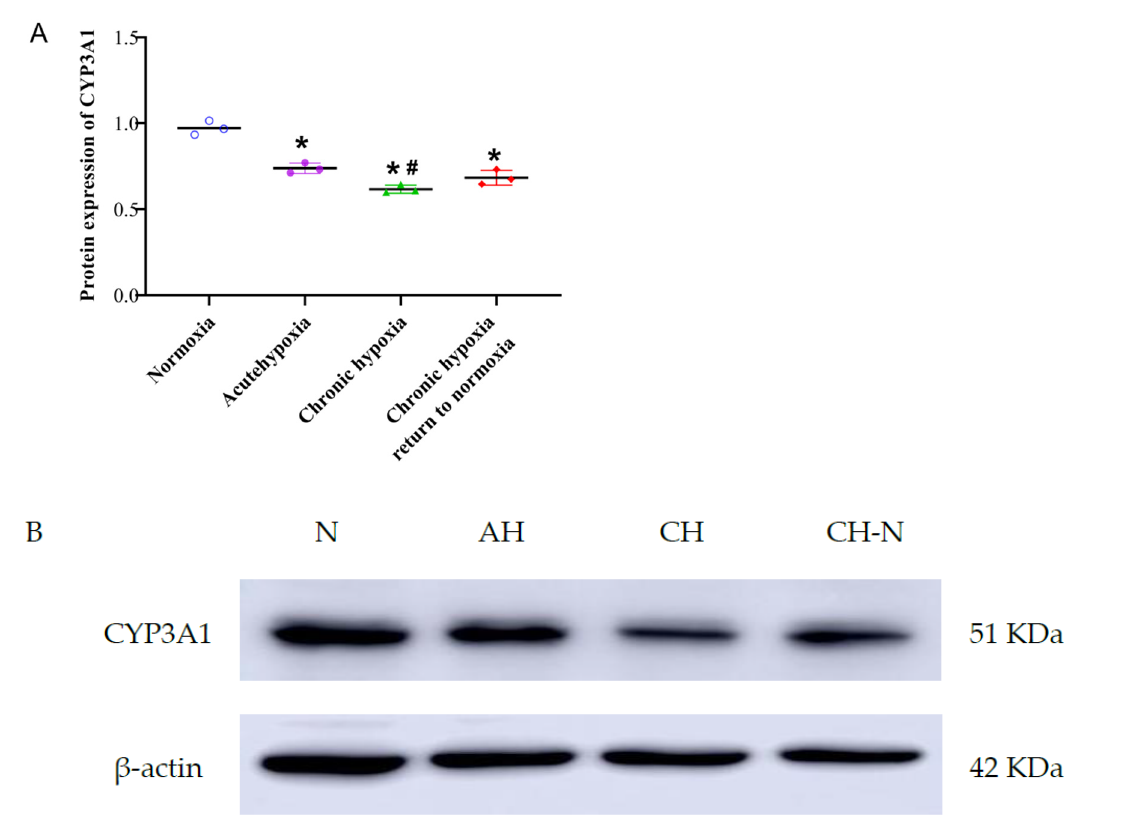
Figure 12. The protein expression of CYP3A1 in rats after exposure to high-altitude hypoxia ( A ). Liver protein expression map of four groups of rats ( B ). N: normoxia group; AH: acute hypoxia group; CH: chronic hypoxia group; CH-N: chronic hypoxia to normoxia group. The data are presented as the mean ± SD. n = 3. * p < 0.05 compared to the normoxia group, # p < 0.05 compared to the acute group.